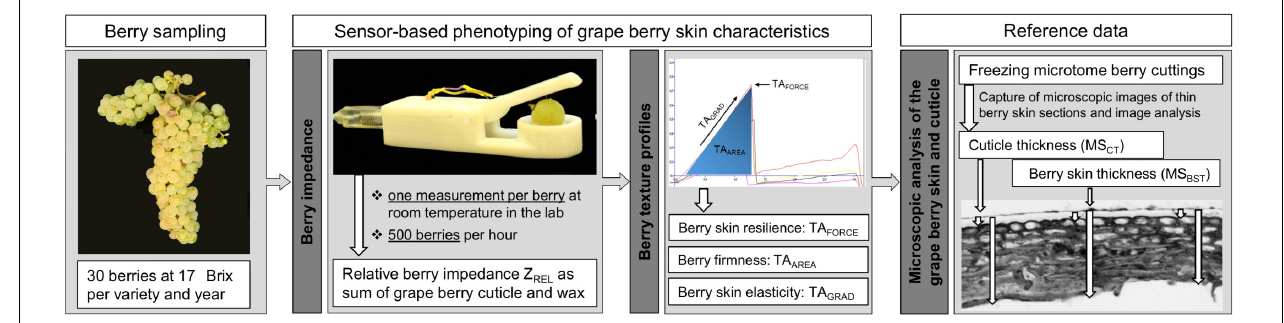
FIGURE 1 | Workflow of phenotyping of different berry skin traits. After berry sampling, berry impedance measurements and texture analysis (TA) were conducted and finally followed by freezing the berries for microscopic